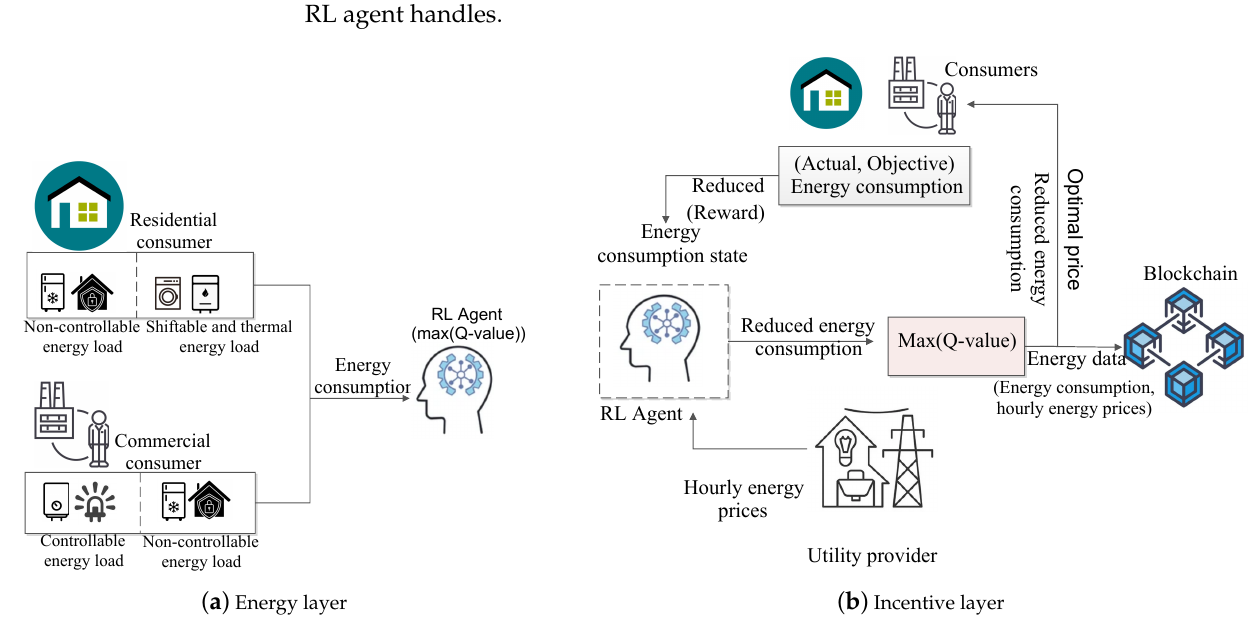
Figure 3. Flowchart for the proposed RI-EMS